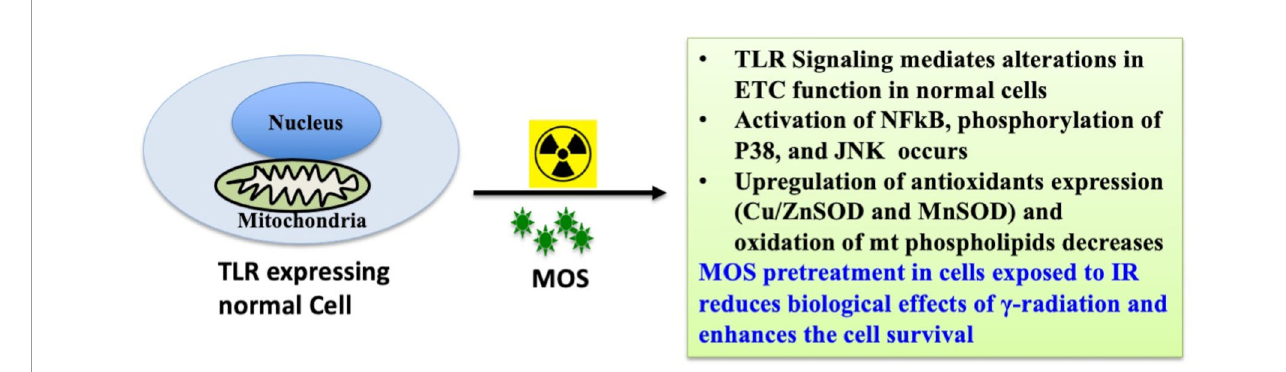
FIGURE 9 | MOS mediated radiation protection in vitro : MOS mediated radiation protection in normal cells requires TLR and ETC function. Under in vitro system, mannan counters radiation response through activation of NF k B, p38 and JNK, alteration in mitochondrial physiology, increase in MnSOD and Cu/ZnSOD expression, and decrease in peroxidation of cardiolipin inside mitochondrial inner